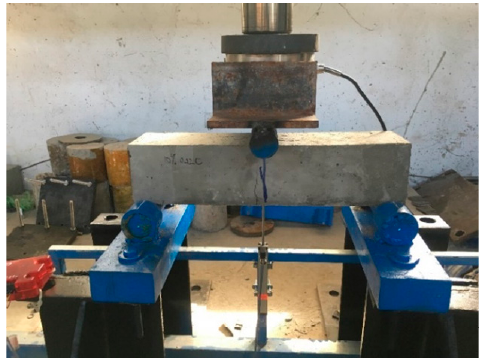
Figure 2. Three point bending test.